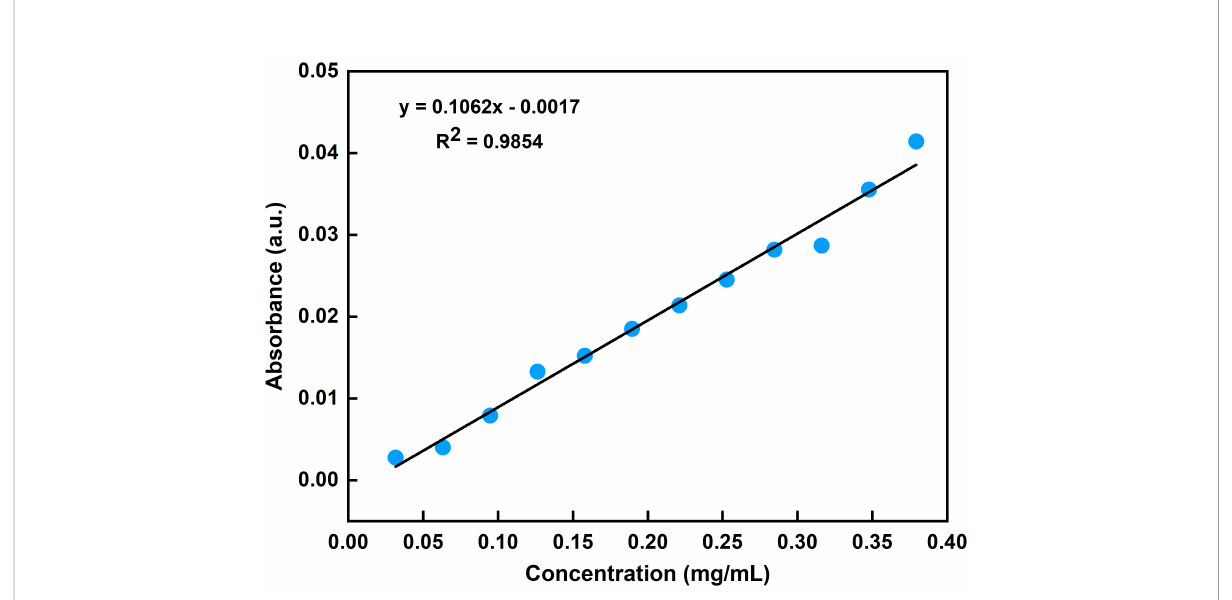
FIGURE 3 FOEW calibration curve of absorption at 1045 cm -1 corresponding to different concentrations of ethanol standard